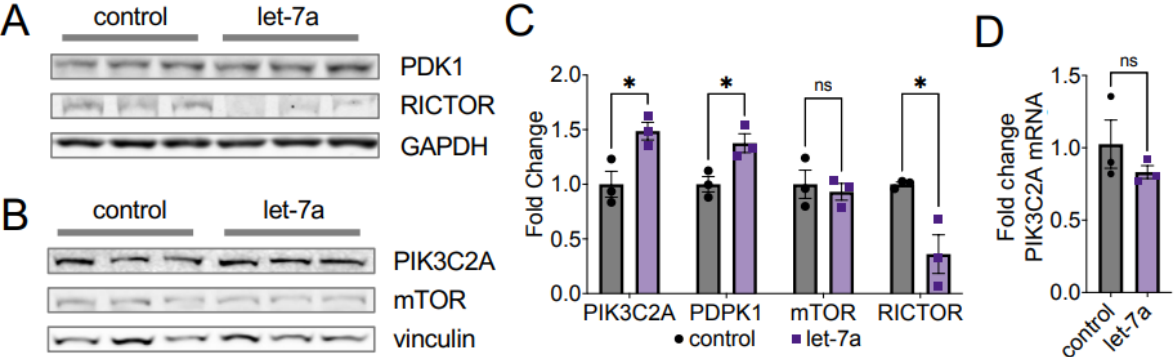
Figure 7. Let-7a deregulates AKT1 phosphorylation via PIK3C2A and RICTOR. ( A , B ) Western blots and ( C ) quantification of PDK1, RICTOR, PIK3C2A, and mTOR in HEK 293T cells transfected 60 fmol let-7a (purple squares) or a control lacking RNA (black circles) for 24 h. Cells in ( A ) were stimulated with EGF for 15 min. ( D ) RT-qPCR of PIK3C2A mRNA from cells transfected with 60 fmol let-7a (purple squares) or a control lacking RNA (black circles) for 24 h and stimulated with EGF for 15 min. The data include n = 3 biological replicates. Error bars show ± 1 SEM. Asterisks indicate significance (ns, not significant; * p < 0.05).